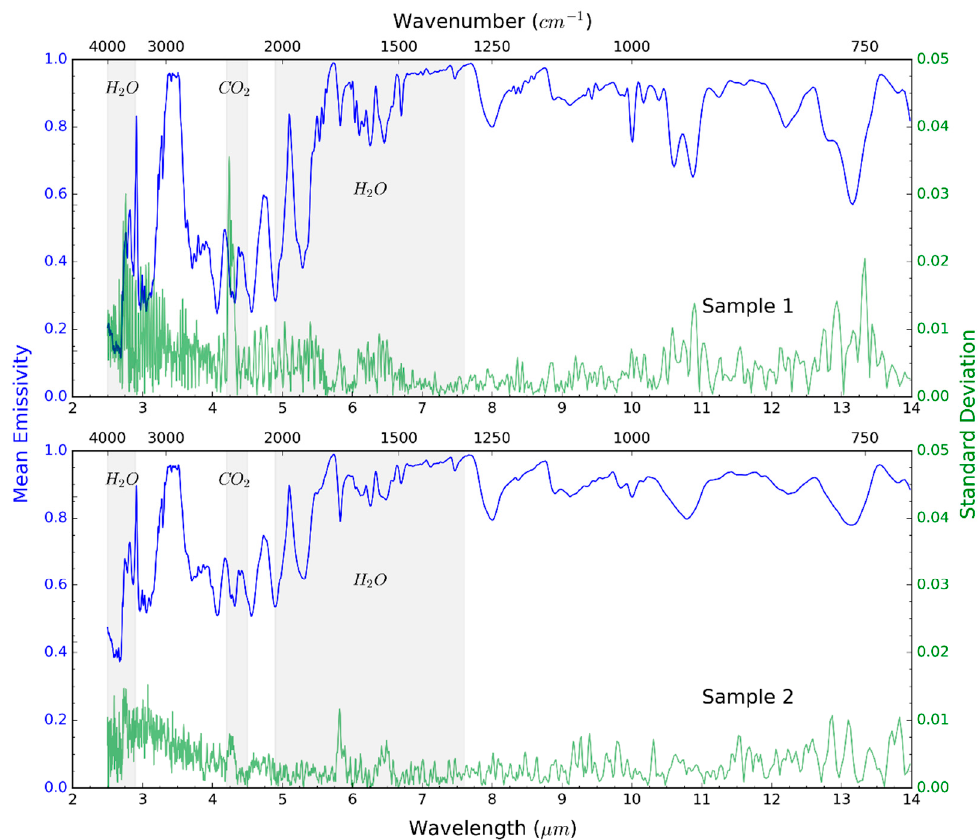
Figure 3. Mean (blue, left axis) and standard deviation (green, right axis) of three spectral emissivity measurements made of Samples 1 and 2 at King’s College London (KCL) at the start of the Round Robin (25 September 2017), midway through (9 October 2018), and at the end (11 September 2019). Each sample emissivity was calculated using the substitution method of calibration, using identical measurement setups, parameters and procedures. The absorption bands of relevant gases (H 2 O and CO 2 ) are indicated through the grey vertical